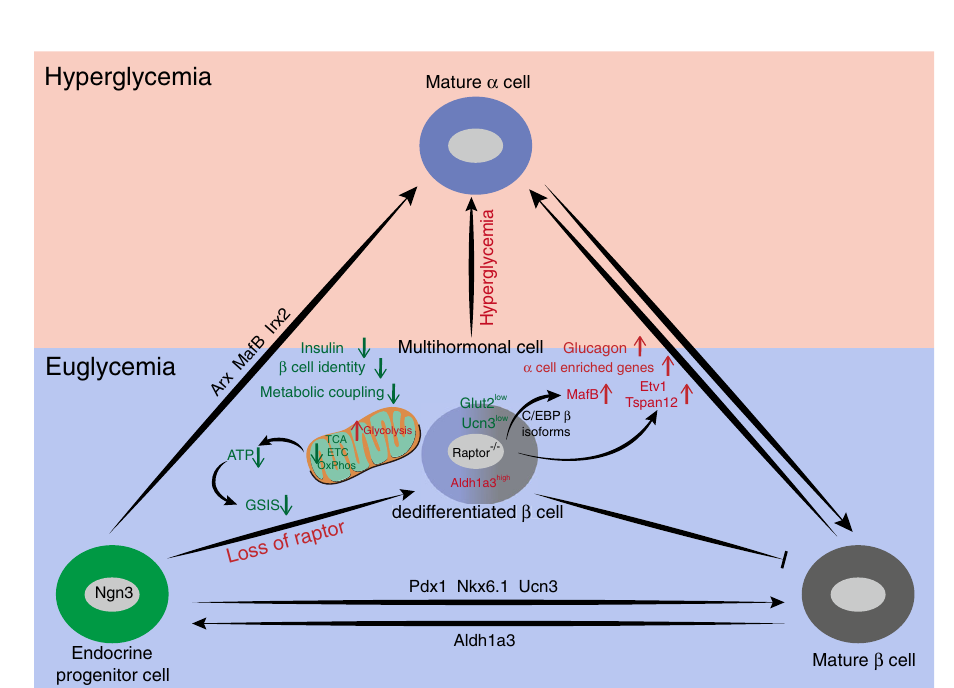
Fig. 7 The role of Raptor in β -cell identity maintenance and α -cell gene repression. Raptor is required for maintaining β -cell identity as well as repressing α -cell signature. At euglycemia, loss of Raptor results in β -cell dedifferentiation (marked as UCN3 low , Glut2 low , and Aldh1a3 high ) with compromised β -cell identity, metabolic uncoupling, and regression to multi-hormonal state with α -cell features. We propose Raptor /C/EBP β / MafB -dependent and MafB - independent ways in silencing α -cell-enriched genes and glucagon expression in healthy β -cells. Raptor -de fi cient β -cells with compromised identity become dysfunctional and eventually cause diabetes; in turn, hyperglycemia further aggravates dedifferentiation and reprogramming